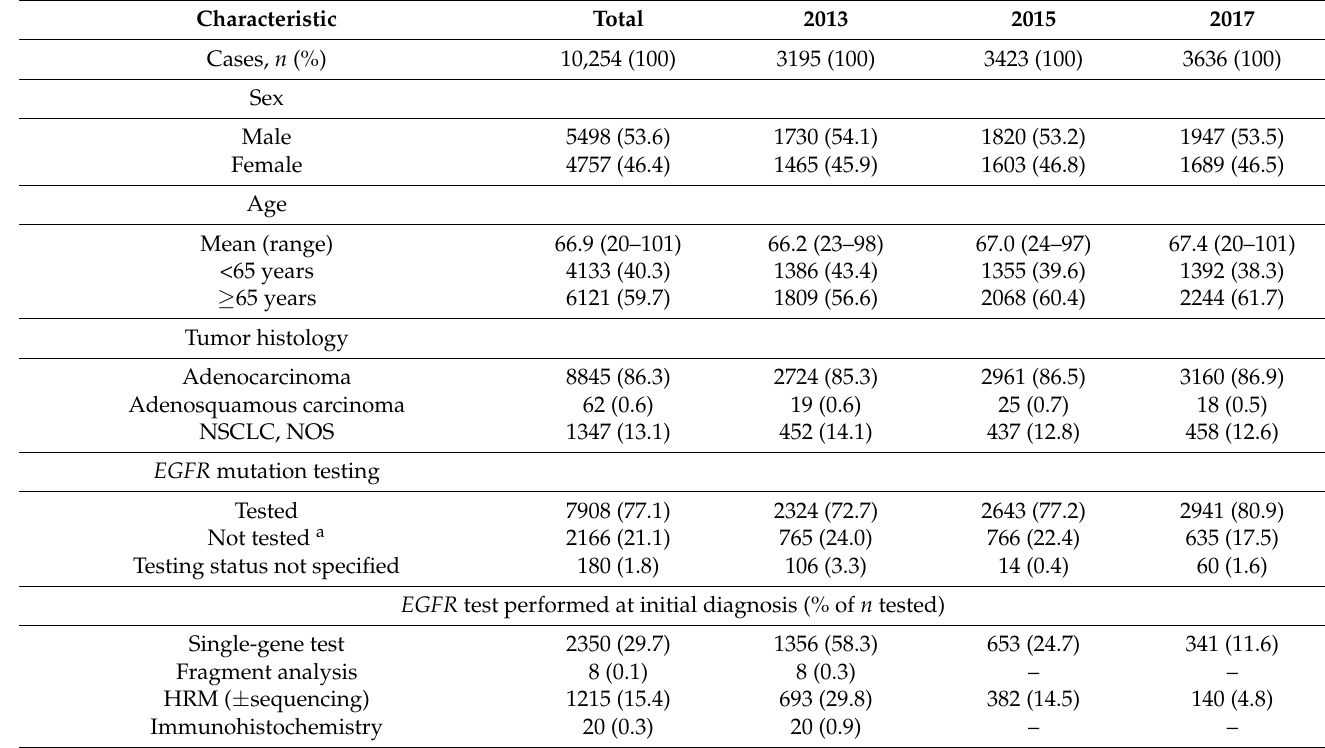
Table 1. Patient characteristics, EGFR testing method and mutation status at initial diagnosis of advanced NSCLC.